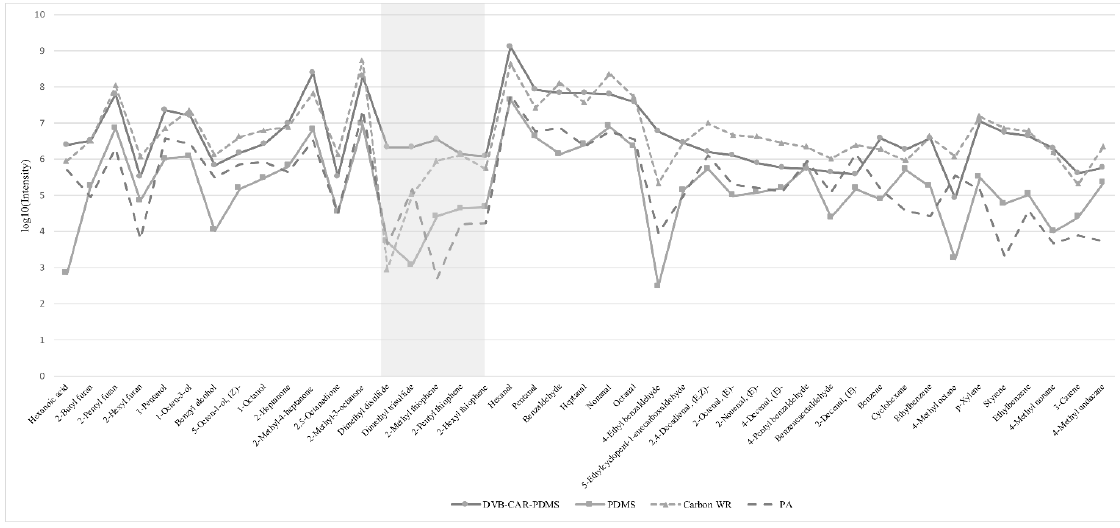
Figure 1. Intensities of typical volatiles detected using different SPME fibers. The shadow in means the emphasis on the sulphur-containing